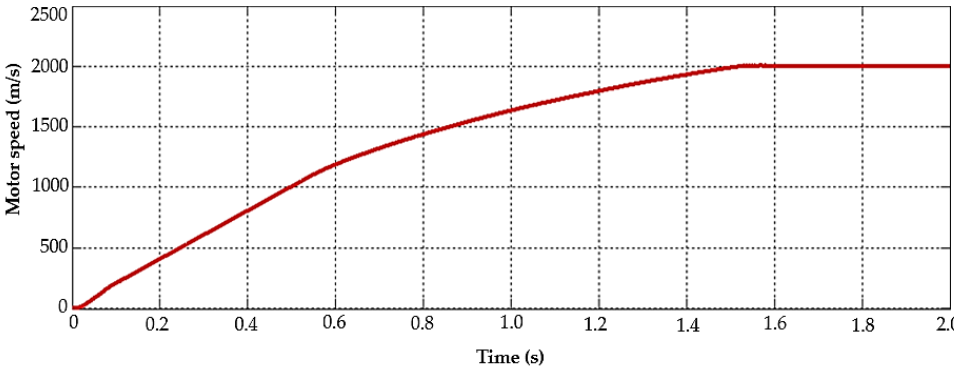
Figure 9. The back emf of the BLDC motor.